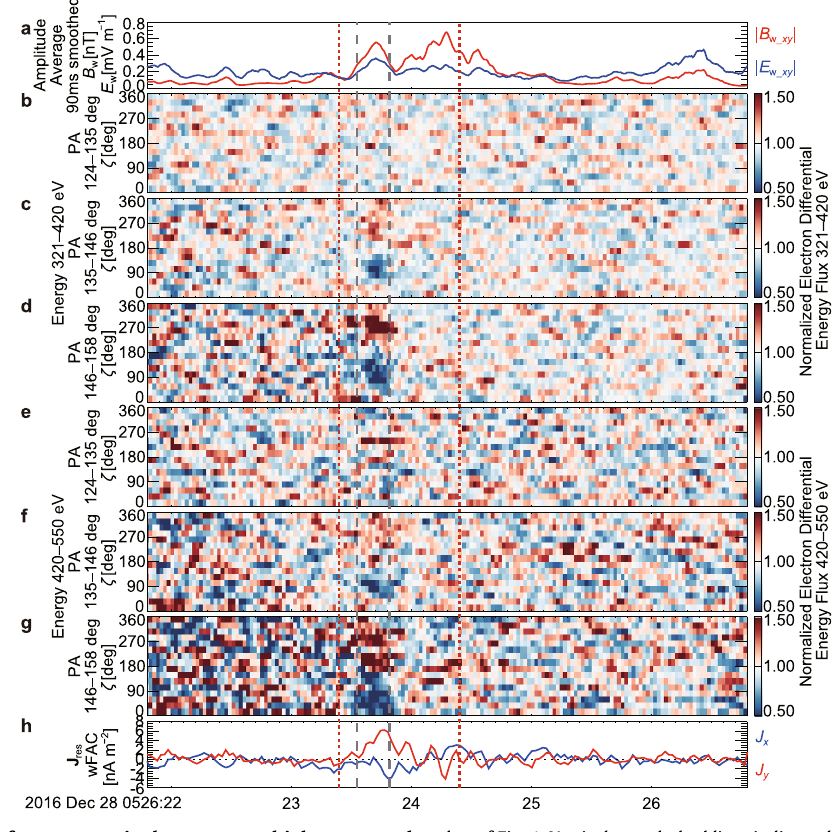
that of Fig. 4. Vertical gray dashed lines indicate the interval analyzed for Supple-